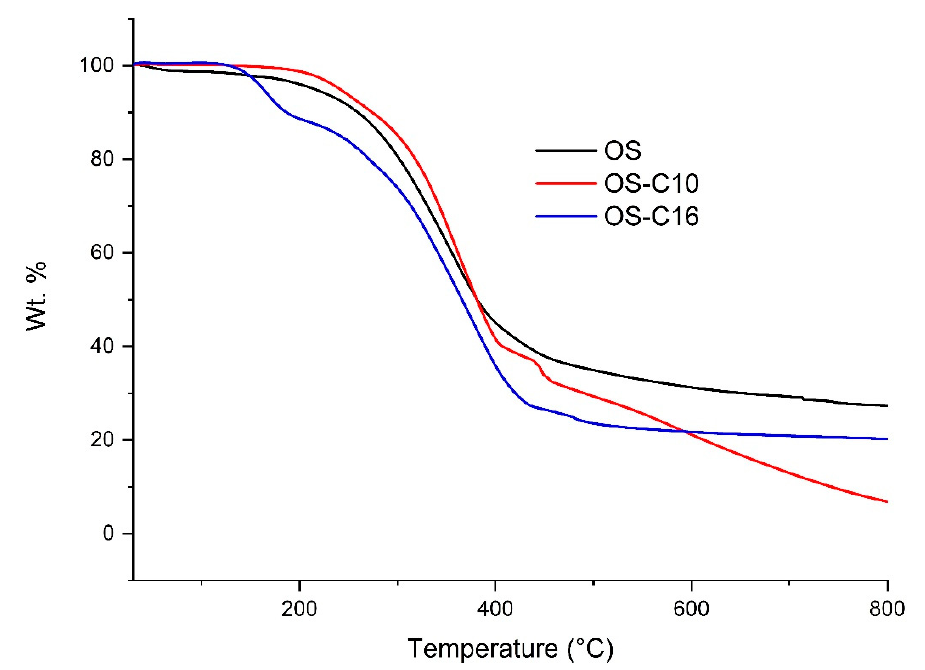
Figure 5. Thermal decomposition graphs obtained under nitrogen atmosphere of non-functionalized and etherified organosolv lignin. and etherified organosolv